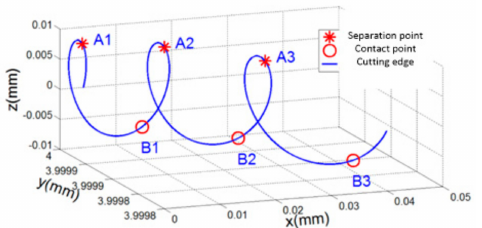
Figure 3. Cutting edge trajectory characteristics in LTUM.